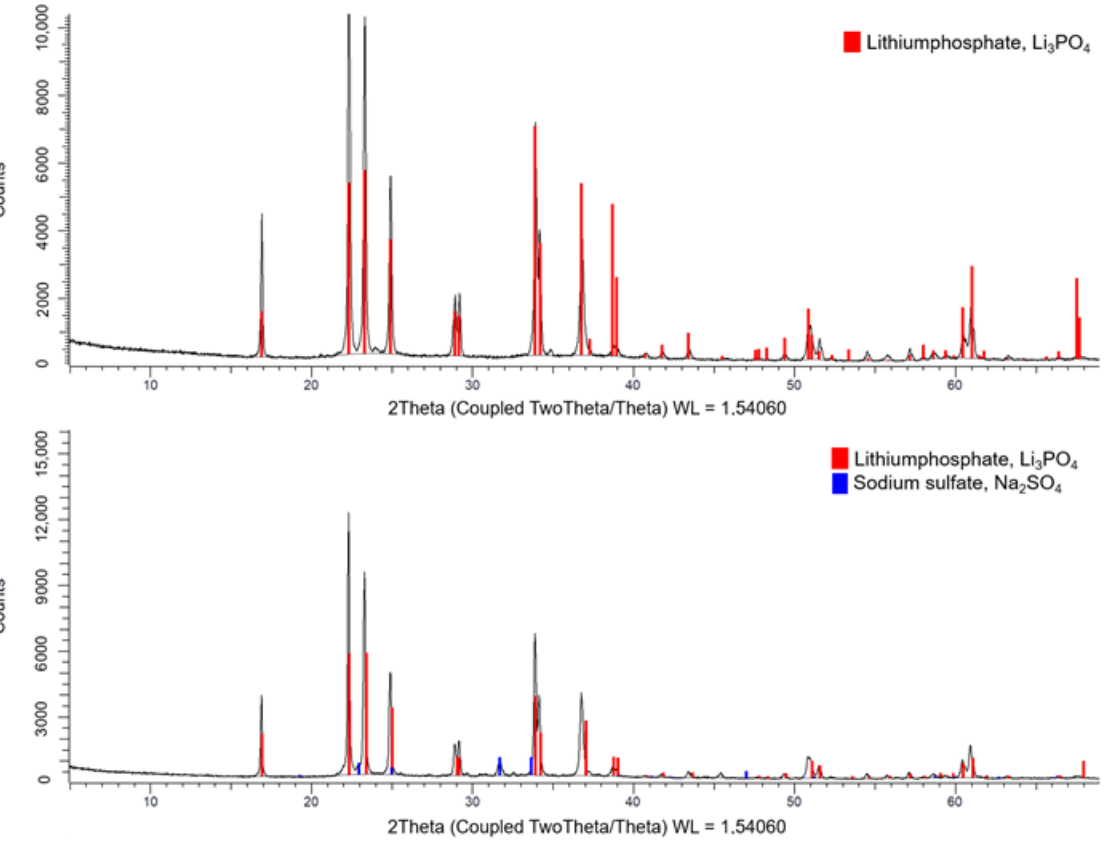
Figure 8. Diffractogram for the precipitation products of the synthetic ( top ) and authentic ( bottom ) starting solution using potassium hydrogen phosphate as precipitant.